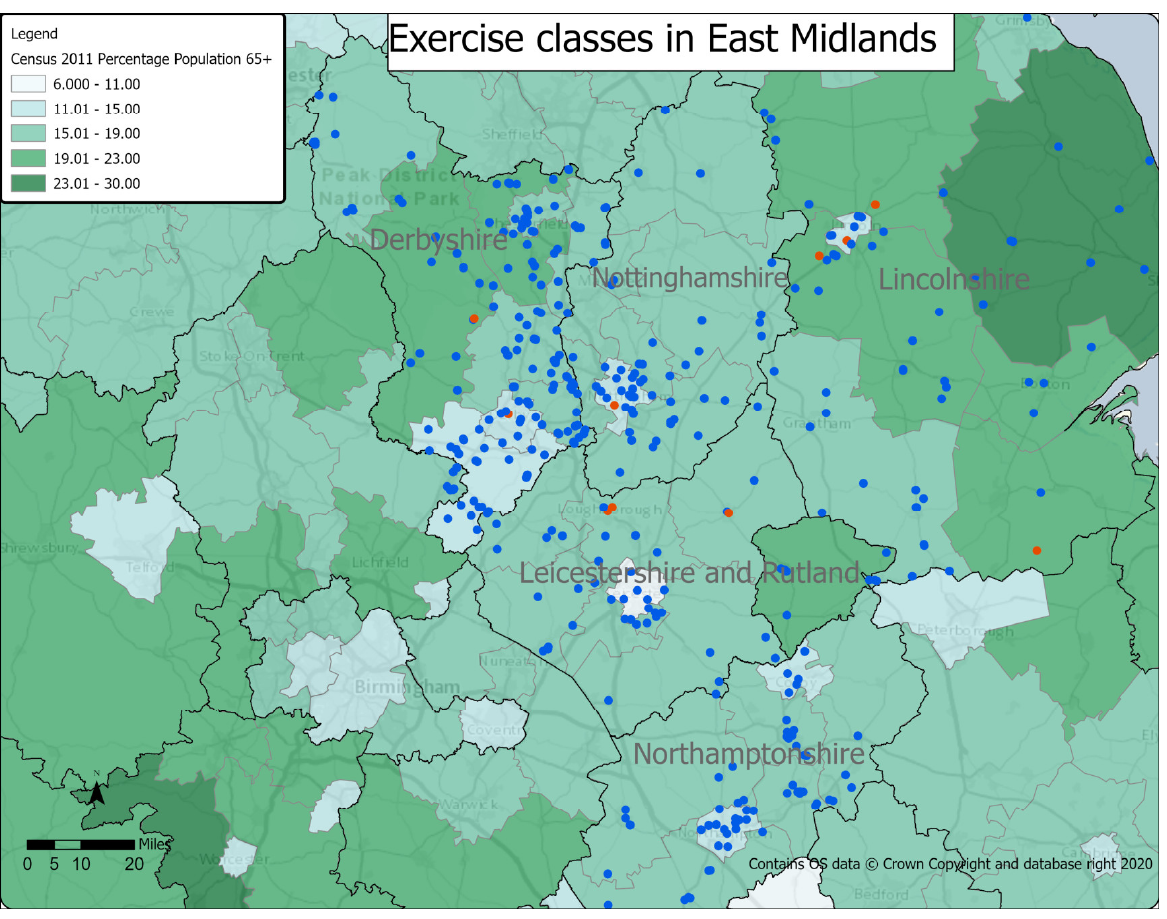
Figure 2. Location of exercise classes in East Midlands, overlaid with the percentage of the population over 65 years.